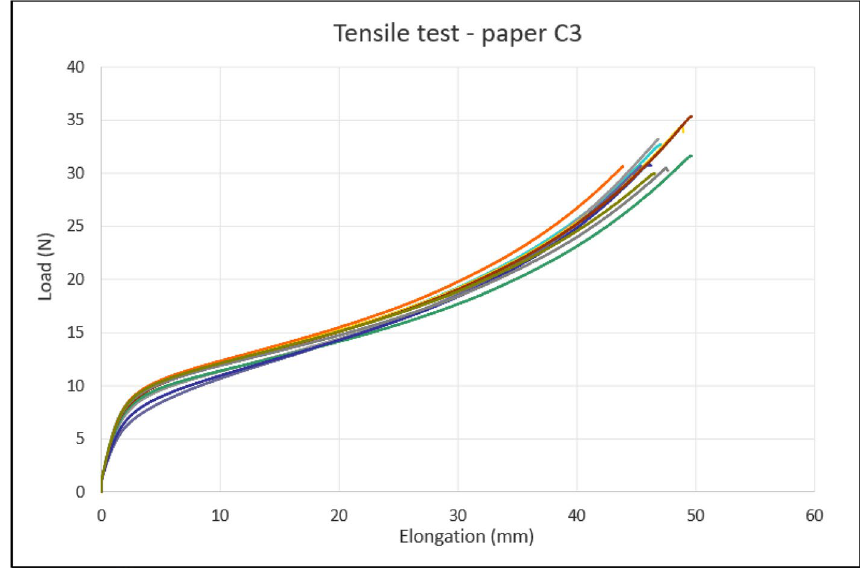
Fig. 29 Force elongation curves of individual specimen of paper